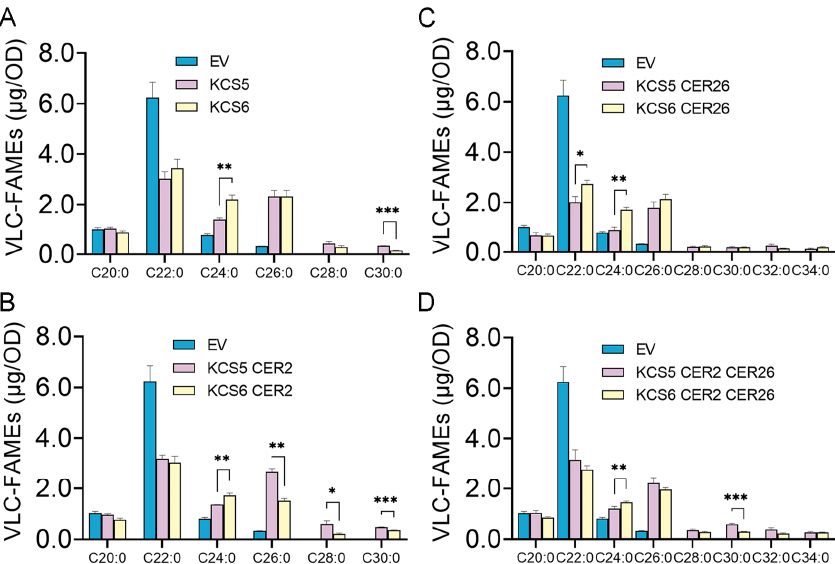
Figure 2. The catalytic activity of KCS5 and KCS6 examined by the yeast system. KCS5 , KCS6, or empty vector (EV) were alone expressed or co-expressed with CER2 and CER26 in yeast strain BY4741 ∆ elo3 ∆ fah1, and the generated products are displayed in the form of VLCFA-FAMEs ( A – D ). FAMEs were synthesized by transmethylation before GC analysis. The values shown are mean ± SD ( n = 4). * p < 0.05; ** p < 0.01; *** p <